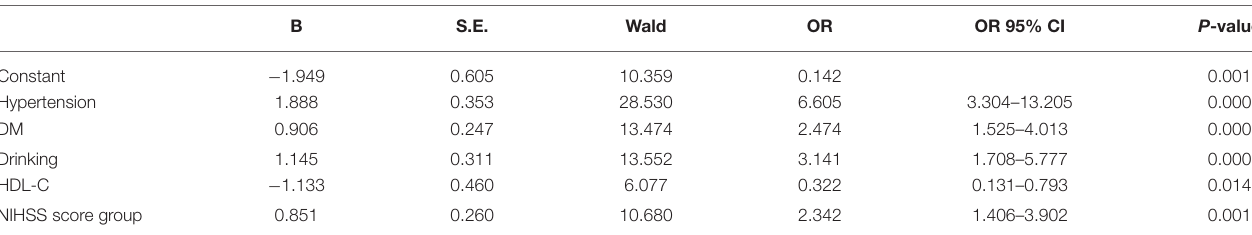
TABLE 6 | Multivariate logistic regression analyses of the risk factors associated with post-stroke anxiety (PSA) evaluated by SAS scale.